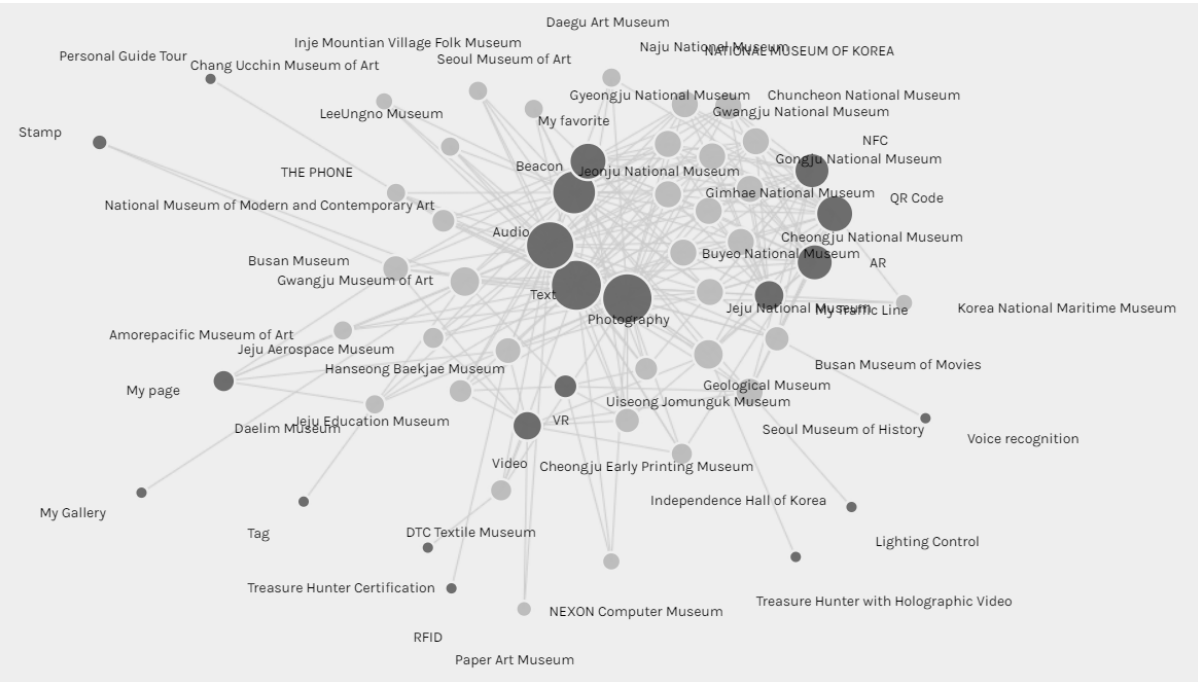
Figure 5. Visualisation of the various technologies adopted in total 36 museum applications from 2011 to